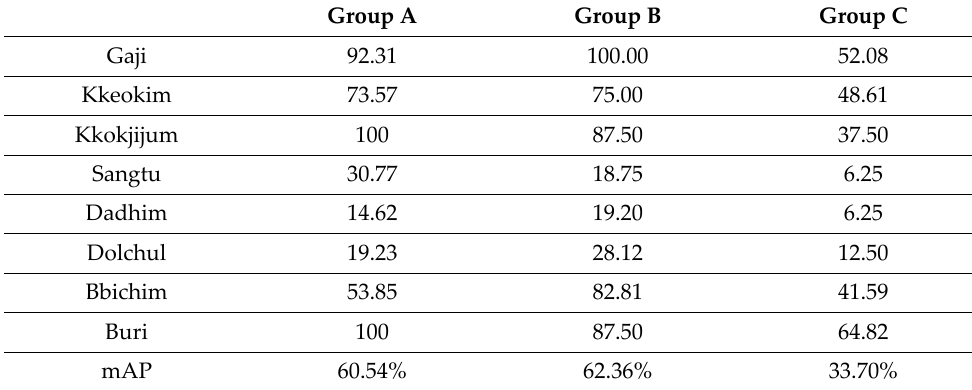
Table 5. Performance of the Stroke Element Detection Model for Structured, Semi‑structured, and Unstructured